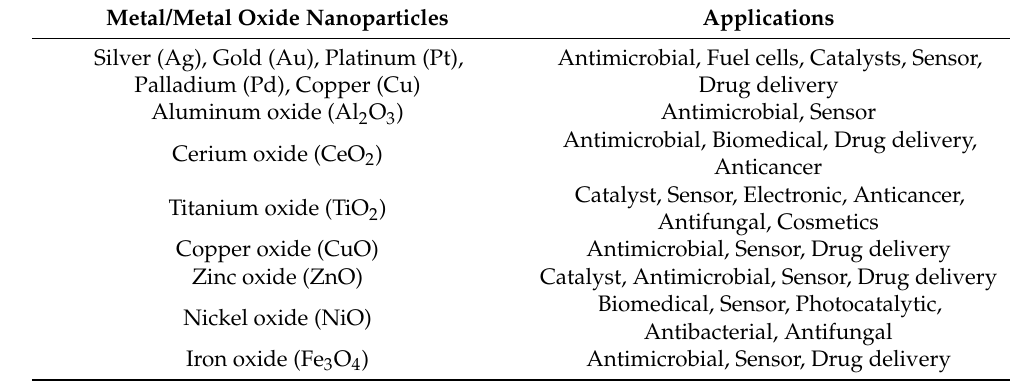
Table 2. Applications of green synthesized metal and metal oxide nanoparticles. Elaboration from refs.